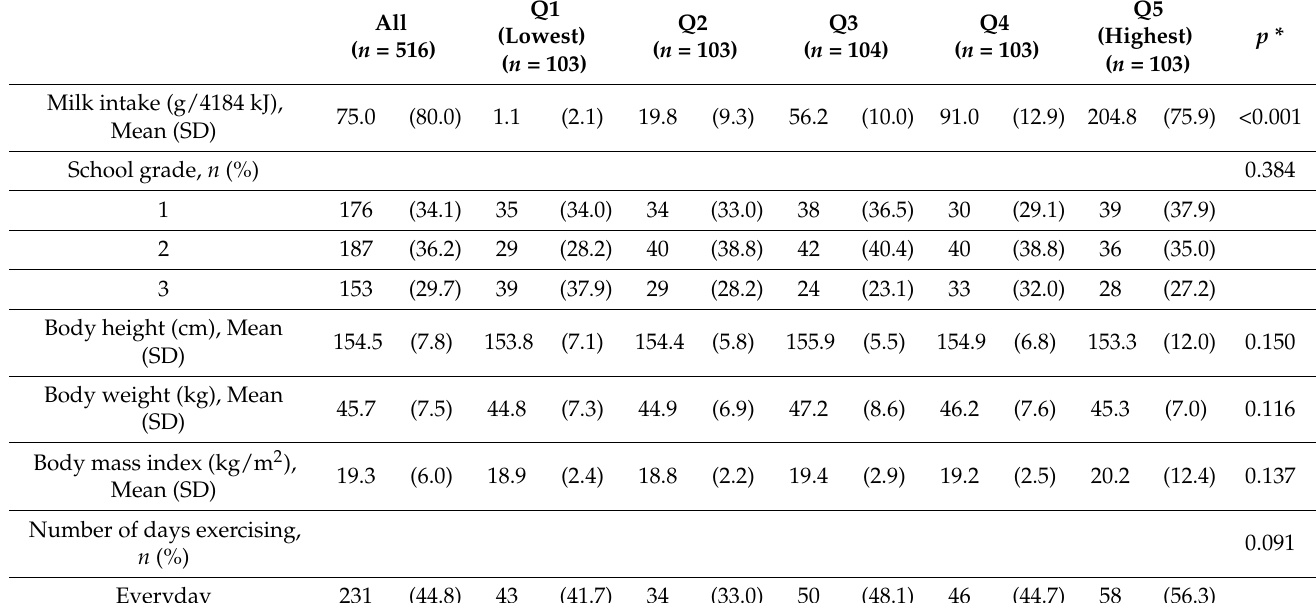
Table 1. Characteristics of 516 Japanese female junior high school students classified into five groups according to milk